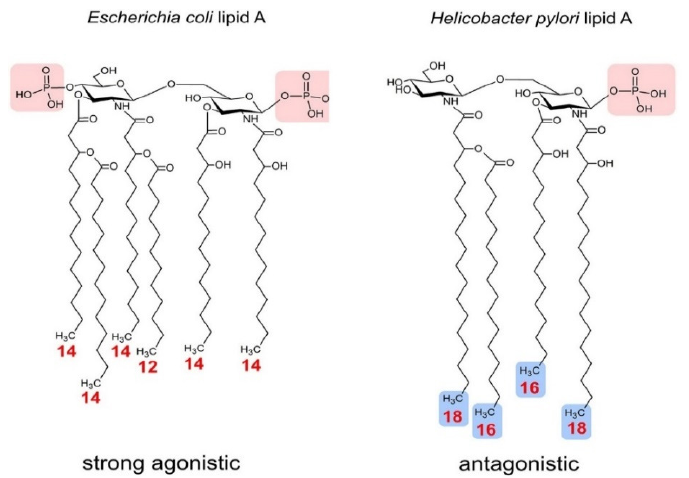
Figure 2. Structures of Escherichia coli (strong agonistic) and Helicobacter pylori (antagonistic). Escherichia coli Lipid A consists of six acyl chains (hexa-acylated) and two immunogenic phosphate groups (Light red); in contrast, H. pylori Lipid A is composed of four acyl chains (tetra-acylated) and one immunogenic phosphate group (light red). Structural differences of the acyl chains and modifications in phosphate groups significantly alter the immunogenic activity of Lipid A molecules (Adapted from Steimle, A. et al. [66]).